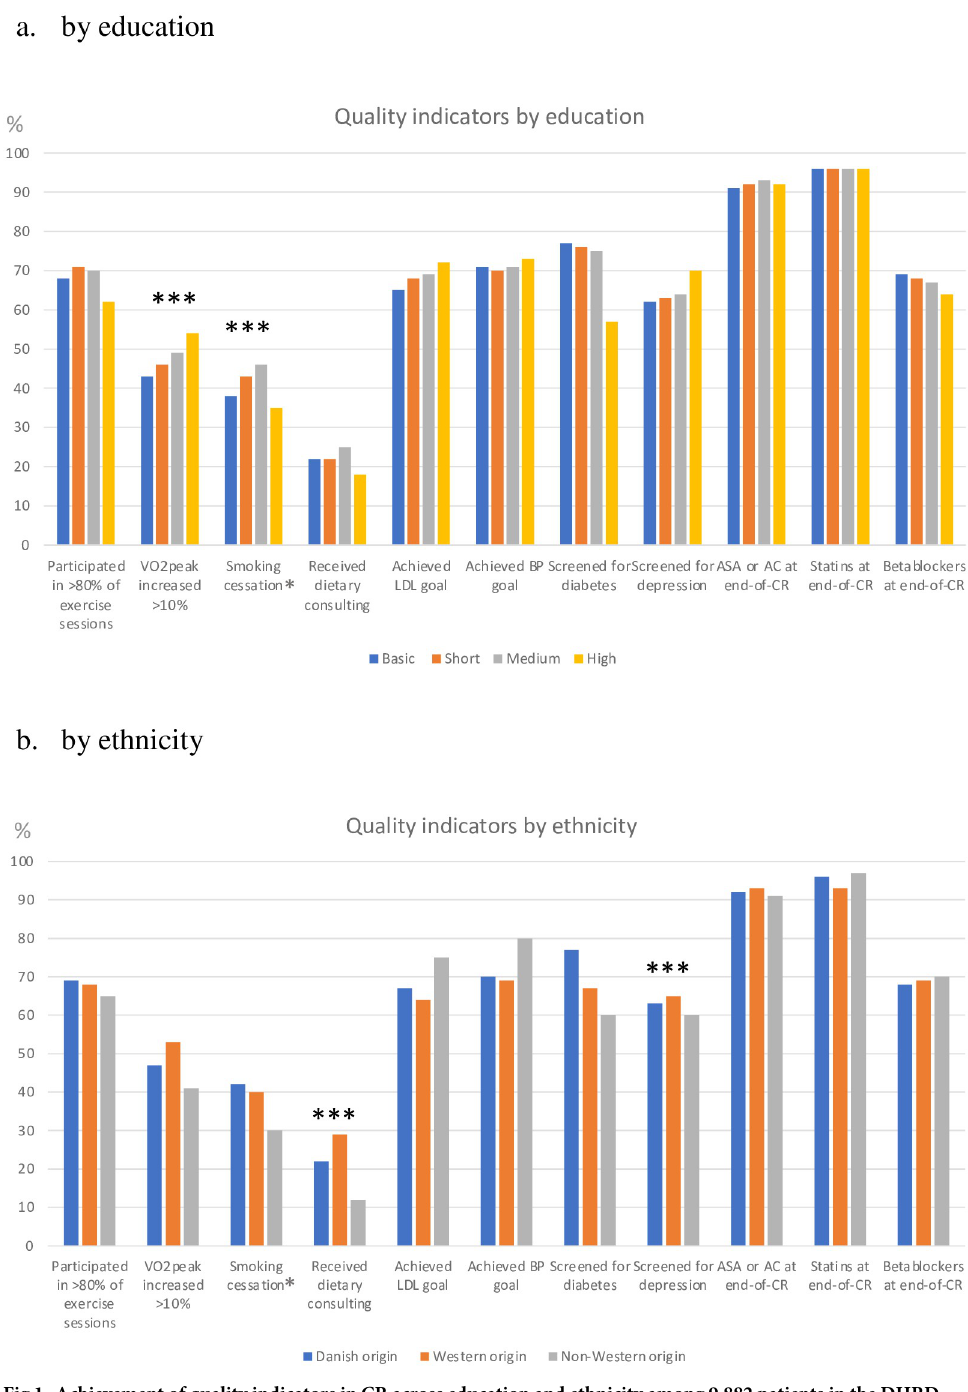
Fig 1. Achievement of quality indicators in CR across education and ethnicity among 9.882 patients in the DHRD population. a. by education and b. by ethnicity. ��� p-value < 0.05, adjusted for gender, age, comorbidity index, diabetes, hypertension, hypercholesterolemia and previous CHD; � smokers at baseline. Abbreviations: VO 2peak : peak oxygen consumption, LDL: Low density lipoprotein, BP: blood pressure, ASA; acetylsalicylic acid, AC: anticoagulants, CR: cardiac